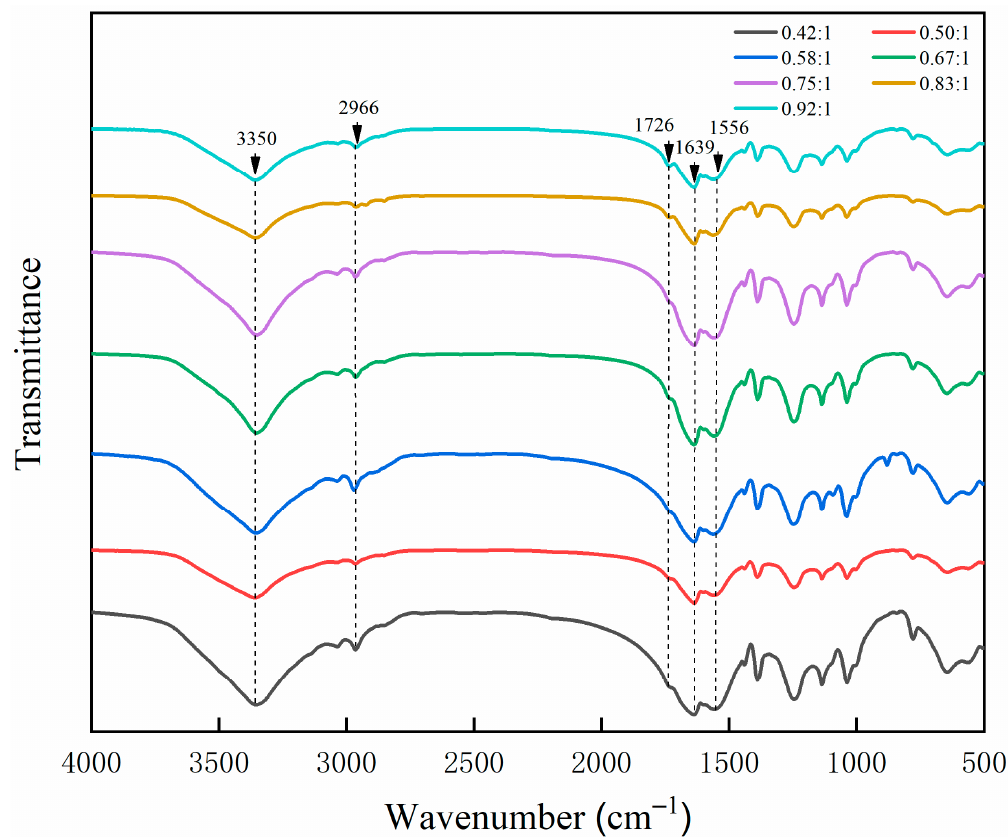
Figure 7. FTIR spectrum of microcapsules by single factor experiment.